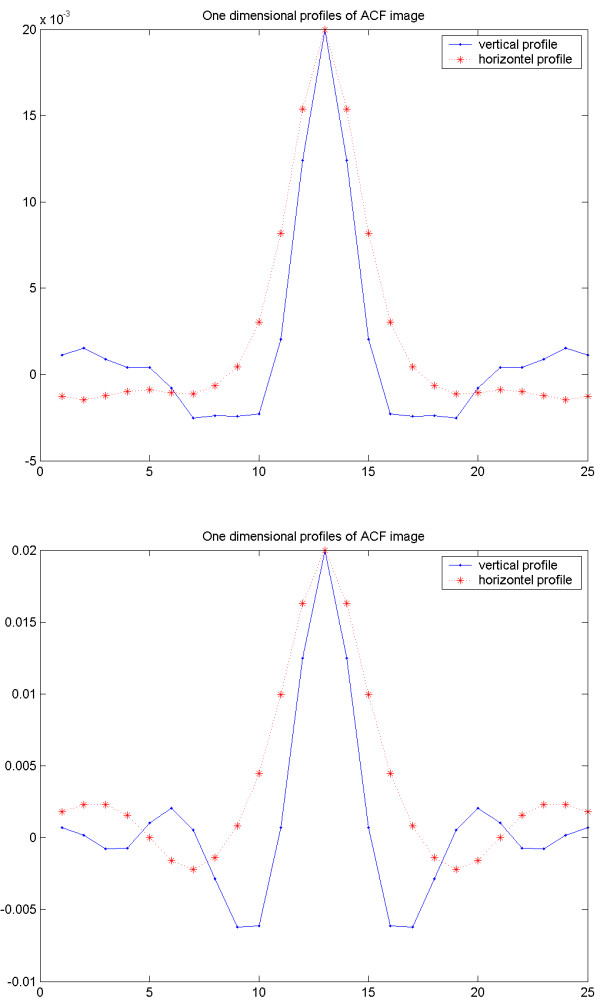
Results of the elliptical torso phantom study. Vertical (dash point) and horizontal profile (dash star) through the centre of the ACF image obtained with 2D (upper) and 3D acquisition (lower) reconstructed using FBP with 6 mm Gaussian filter.